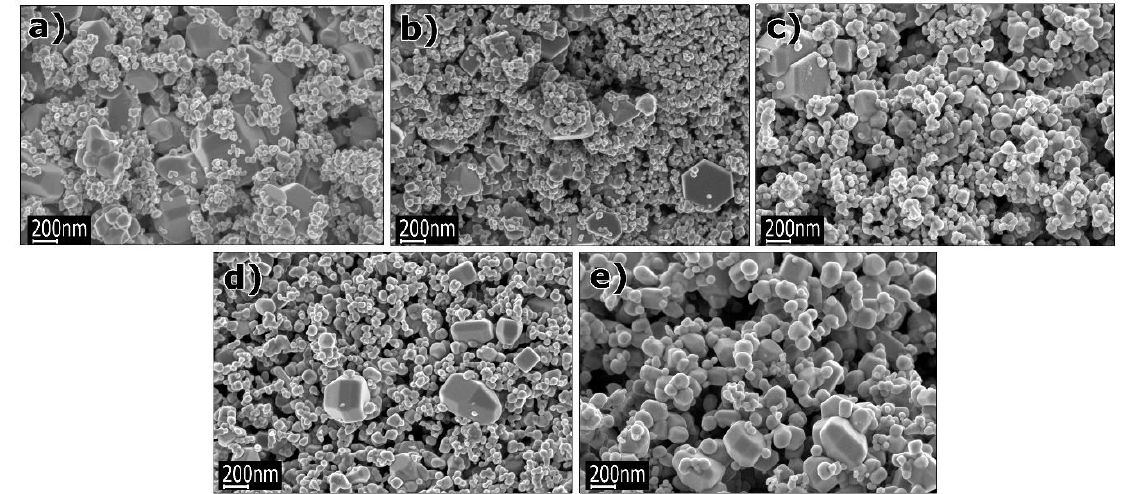
Figure 61. SEM images of annealed ZnO nanopowders after annealing at 800 °C in synthetic air: ( a ) undoped, ( b ) doped with 1 mol% of Co 2+ , ( c ) 5 mol% of Co 2+ , ( d ) 10 mol% of Co 2+ , and ( e ) 15 mol% of Co 2+ ions. Reprinted with permission from [798], Copyright © 2015 Wojnarowicz et al., Article licensed under a CC BY 2.0.